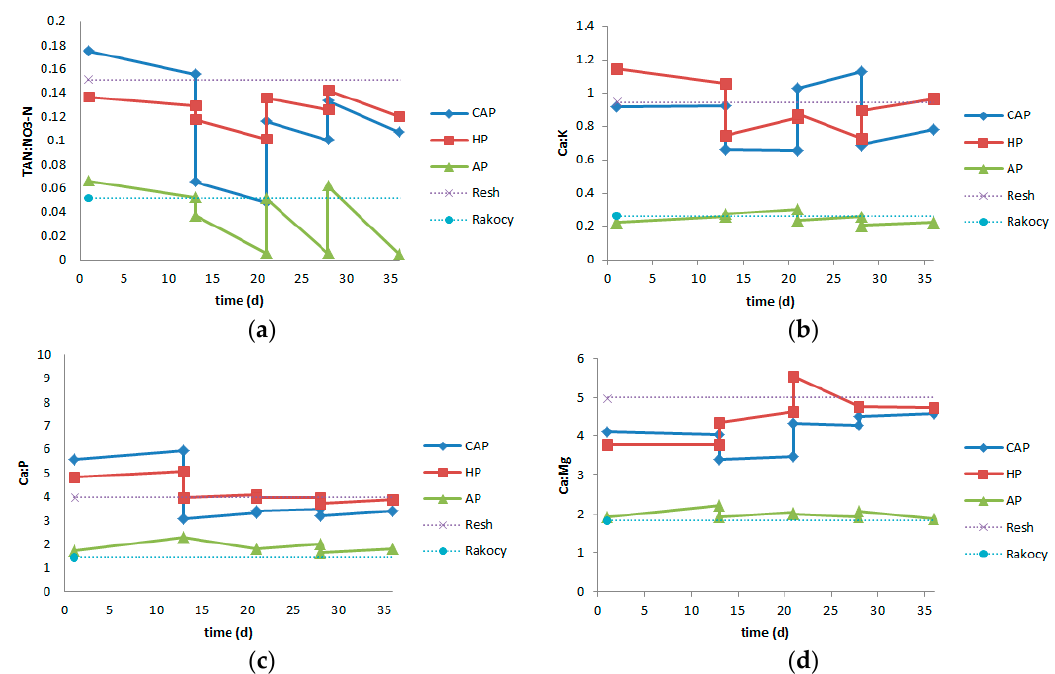
Figure 1. LS mean of macronutrient concentration ratio evolution in complemented aquaponic (CAP), hydroponic (HP), and aquaponic (AP) treatments during trial 2. Resh’s and Rakocy’s ratios are given for comparison. ( a ) TAN to NO 3 − ‐ N ratio; ( b ) Ca 2+ to K + ratio; ( c ) Ca 2+ to P ratio; ( d ) Ca 2+ to Mg 2+ ratio.